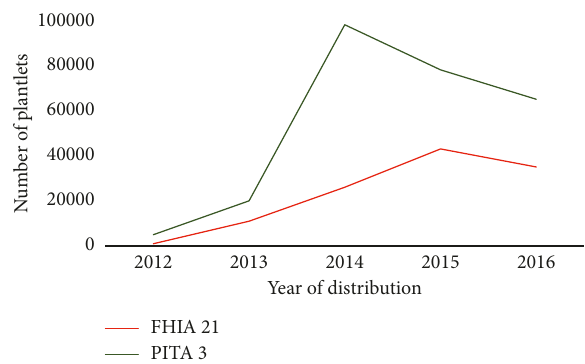
Figure 7: Distribution of in vivo plants of plantain tetraploid hybrids PITA 3 and FHIA 21 from 2012 to 2016 in Cˆote